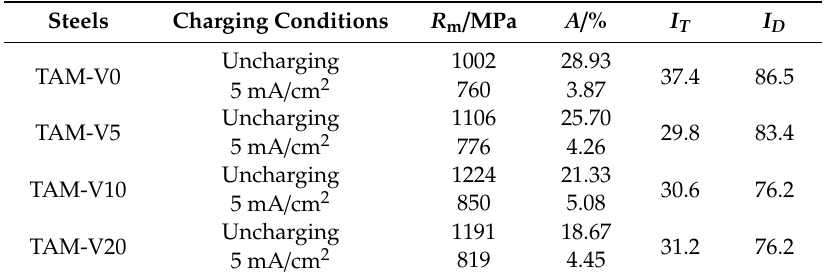
Table 5. Slow strain rate tensile tests (SSRT) tensile